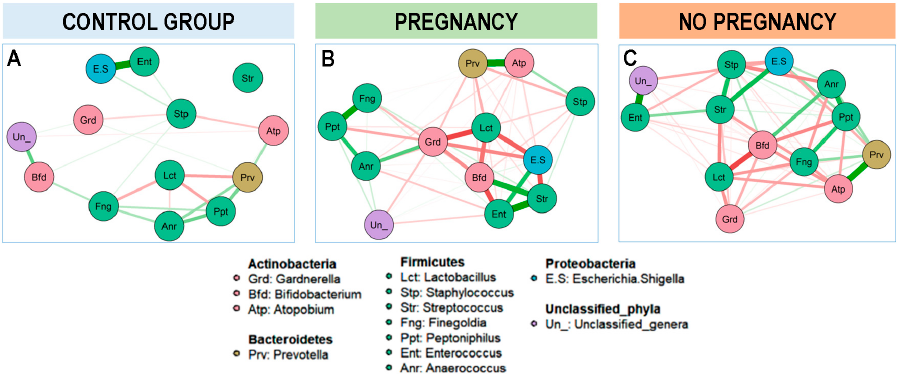
Figure 9. Estimated network structures based on a sample of 58 vaginal samples: 14 from healthy fertile women ( A , Control group), 25 from women with a successful reproductive outcome after the probiotic intervention L. salivarius CECT5713 ( B , Pregnancy) and 19 from women who did not have a successful pregnancy after the probiotic intervention with L. salivarius CECT5713 ( C , No pregnancy). The 14 most abundant genera were represented. Red lines indicate negative correlation and green lines indicates positive correlation. The thickness and the intensity of the line reflects the intensity of the